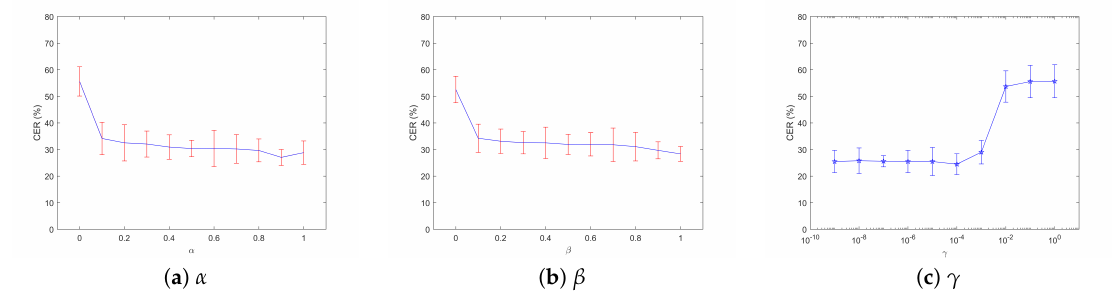
Figure 4. Ablation study in different hyper parameters. ( a – c ) shows model performance in different value of α , β , and γ , respectively. For each value of the parameter in a plot, the horizontal line denotes the error means and the vertical bars indicate their error